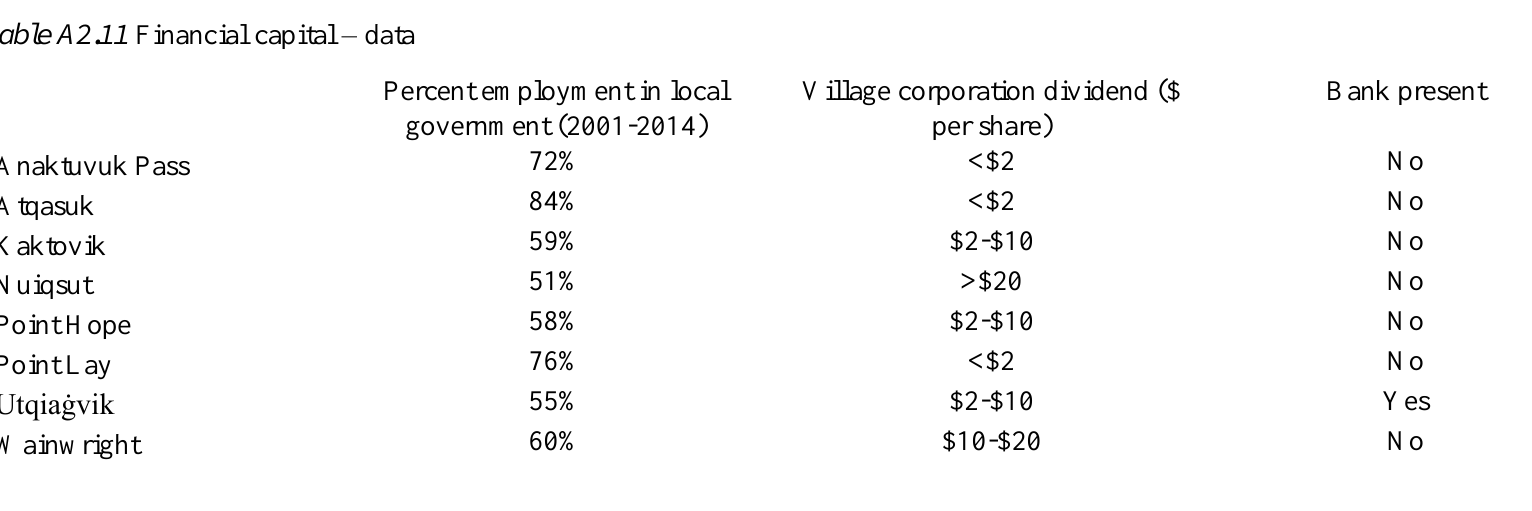
Table A2.11 Financial capital – data